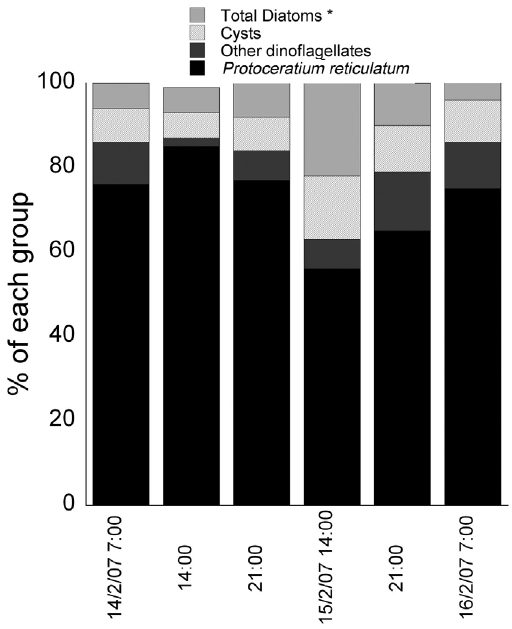
Fig . 4. – Phytoplankton group proportion (% of the total) during the 48-hour cycle at Chipana Bay. * Indicates the sum of diatoms, which can be seen in detail by size in Table 2.